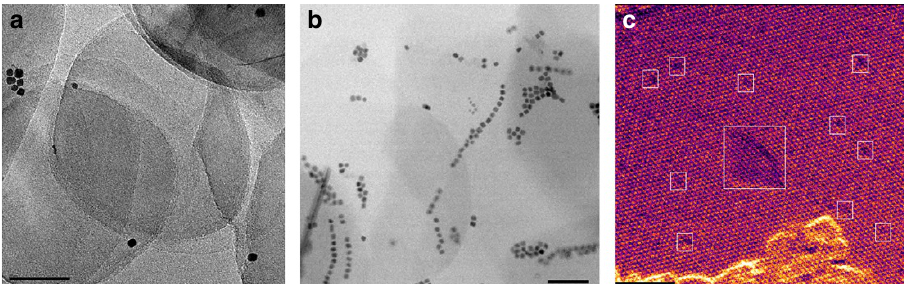
Figure 2 | Representative TEM and STEM images. ( a ) TEM of Pt/ h -BNNS. Scale bar, 50nm. ( b ) STEM of Pt/ h -BNNS. Scale bar, 50nm. ( c ) High- resolution STEM of h -BNNS with vacancies, as indicated by the boxes. Scale bar, 2nm.